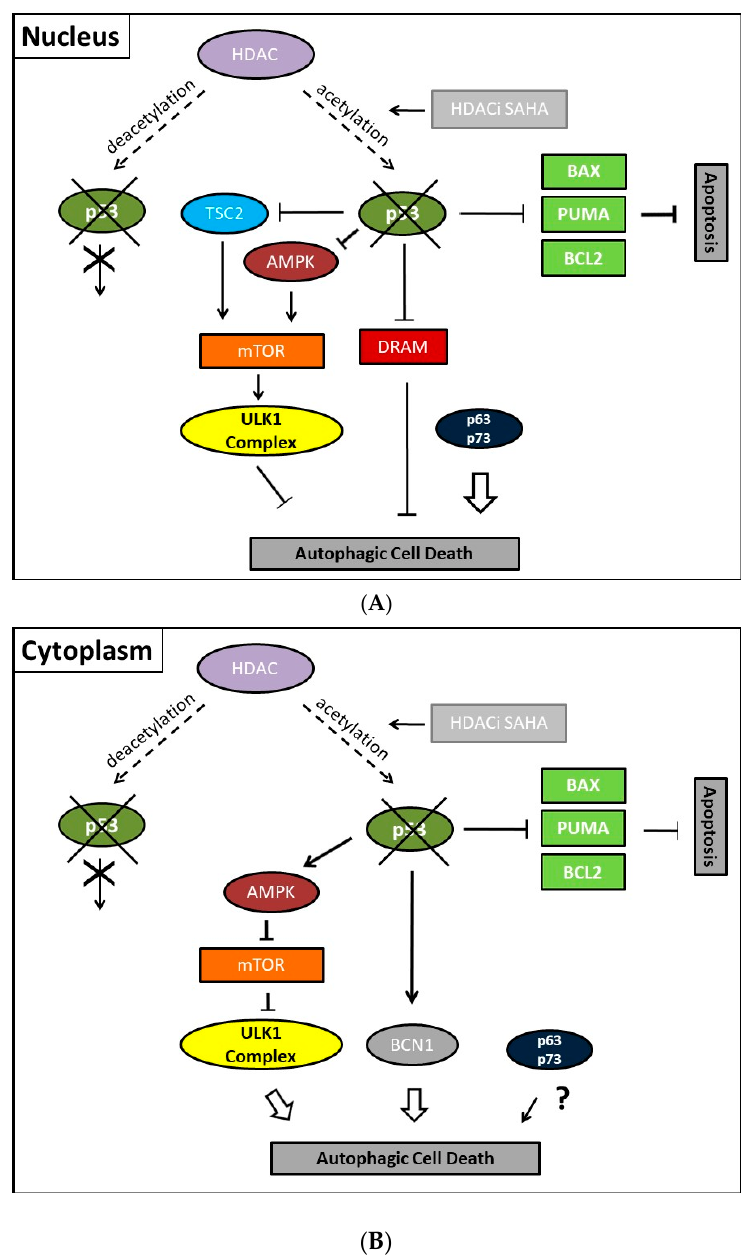
functions for autophagy. Dashed line with arrowhead, deacetylating activity of HDAC; Line with arrowhead (HDACi SAHA), activity of SAHA preventing deacetylation; Fork symbols, transcriptional or enzymatic inhibition by indicated proteins; Arrowlines, transcriptional or enzymatic upregulation or activation by indicated proteins, respectively; Double arrow, major pathway activity.